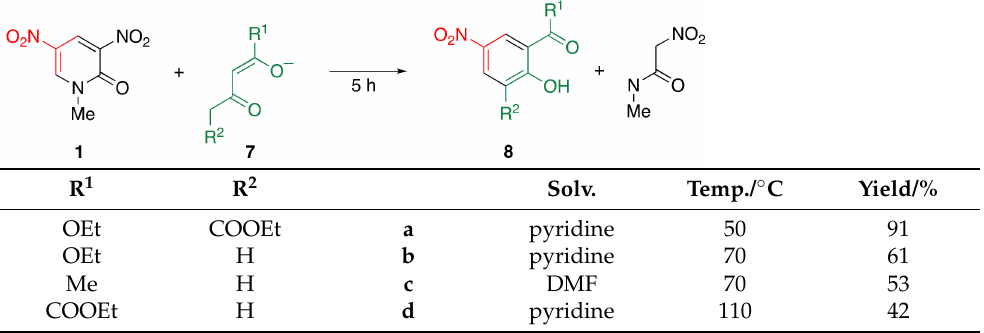
Table 1. Synthesis of functionalized 4-nitrophenols by ring